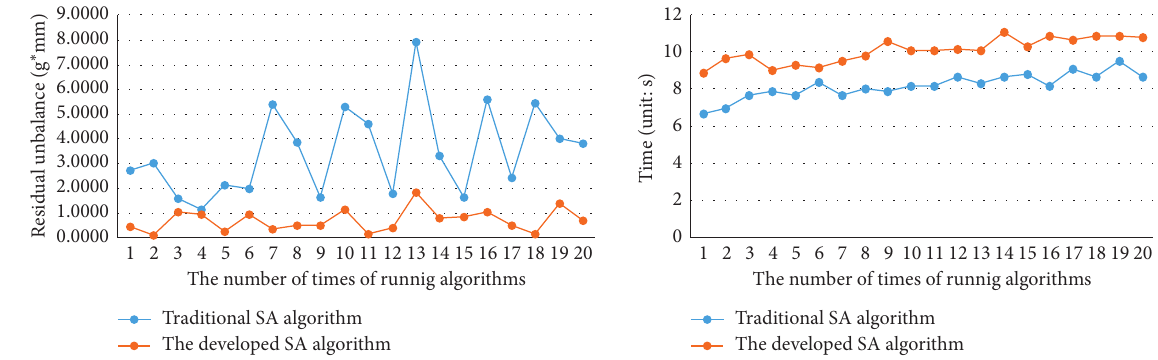
Figure 12: Comparison of solution accuracy and solution time of the traditional SA algorithm and improved SA algorithm. Table 8: The comparison results of the solution effect of the traditional SA and improved SA. Solution accuracy of traditional